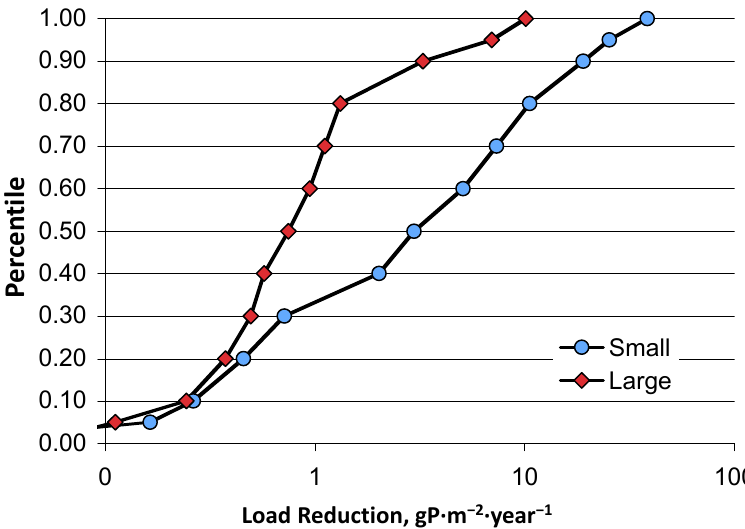
Figure 2. Distributions of P load reductions for large ( N = 43) and small ( N = 87) constructed wetlands.